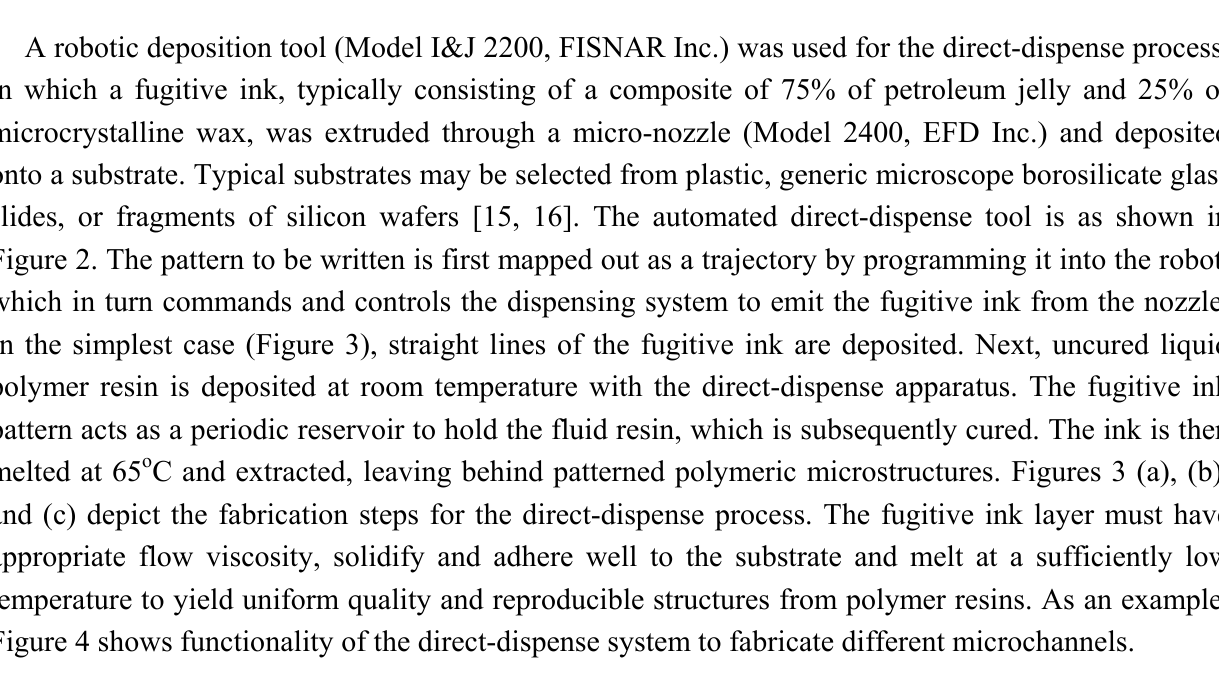
Figure 2. Direct-dispense microfabrication